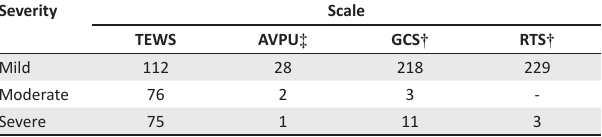
TABLE 3: Severity of head